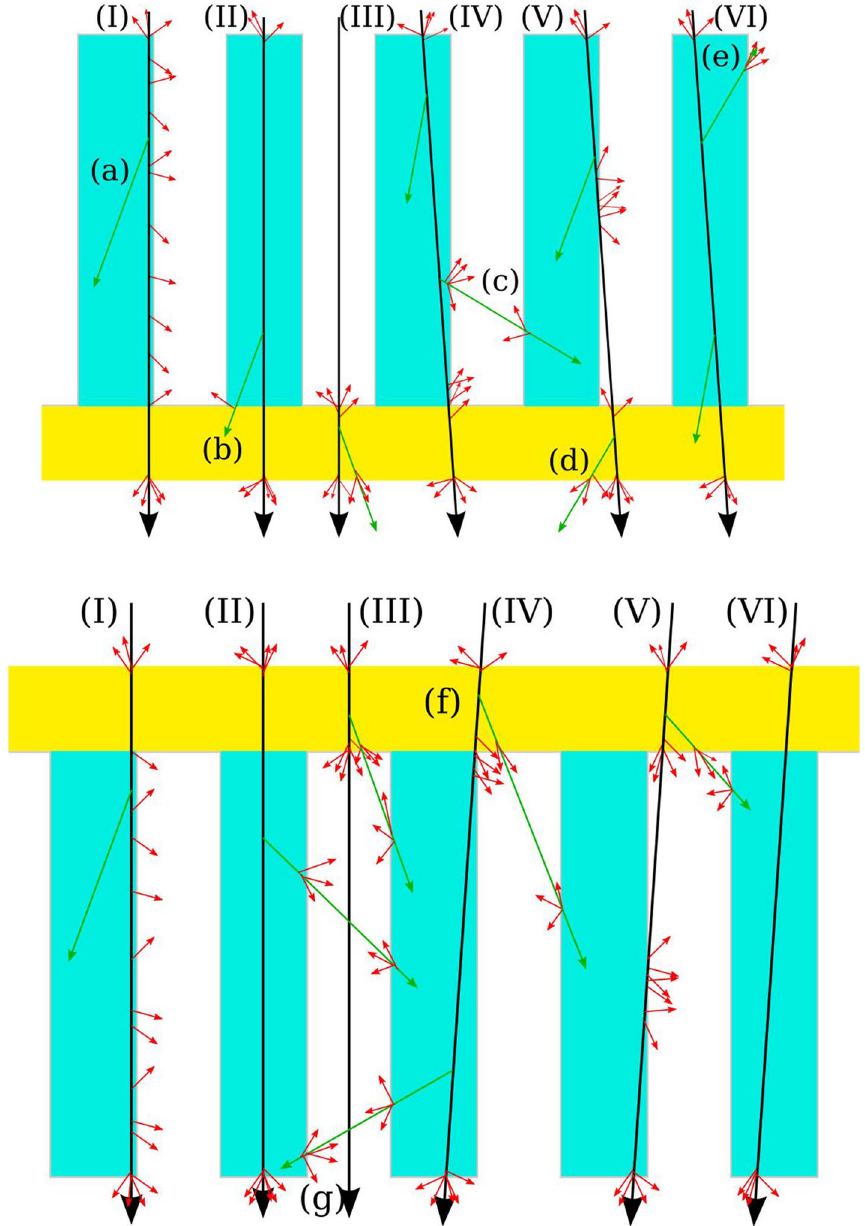
Figure 4. ( a ) Schematic drawing of possible interactions with ions (black) with sample (I–VI). The maximum angle with which ions could have passed through the sample is below 4°. Here, emission in a backward direction is shown. Emission of slow electrons (red) can only occur near the surface. Moreover, delta-electrons (green) can cause emission of the slow electrons near the surface ( a – e ). ( b ) Same as ( a ) but emission in forward direction is shown. Essentially, its difference to ( a ) is that delta-electrons from the window can hit the rods. This is also the case with ( f ), and mostly in forward directions emitted delta-electrons come closer to the end of the rods ( g